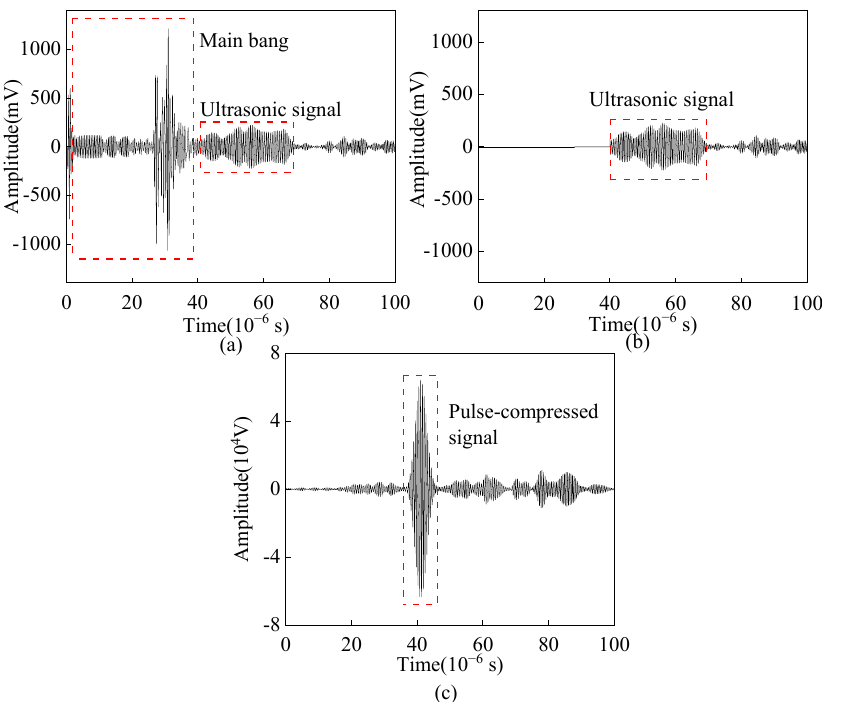
Figure 27. ( a ) Original A-scan signal ( b ) A-scan signal after removal of electromagnetic crosstalk ( c ) Pulse-compressed signal received by angled SV wave EMAT.